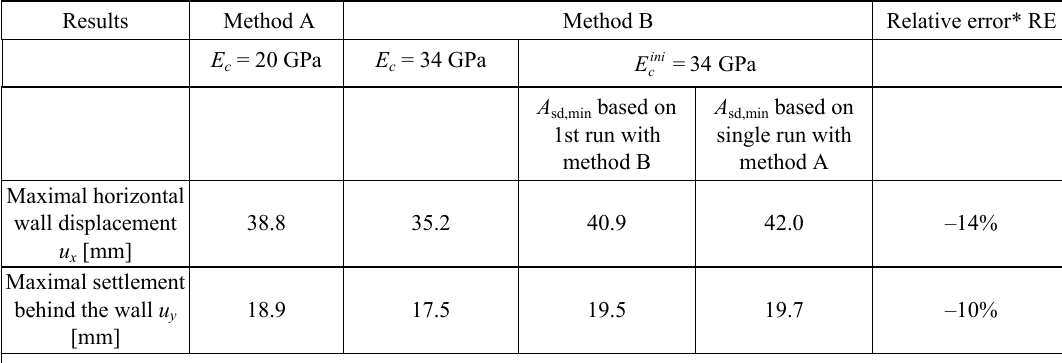
Table 3. Comparison of maximal displacements obtained with Methods A and